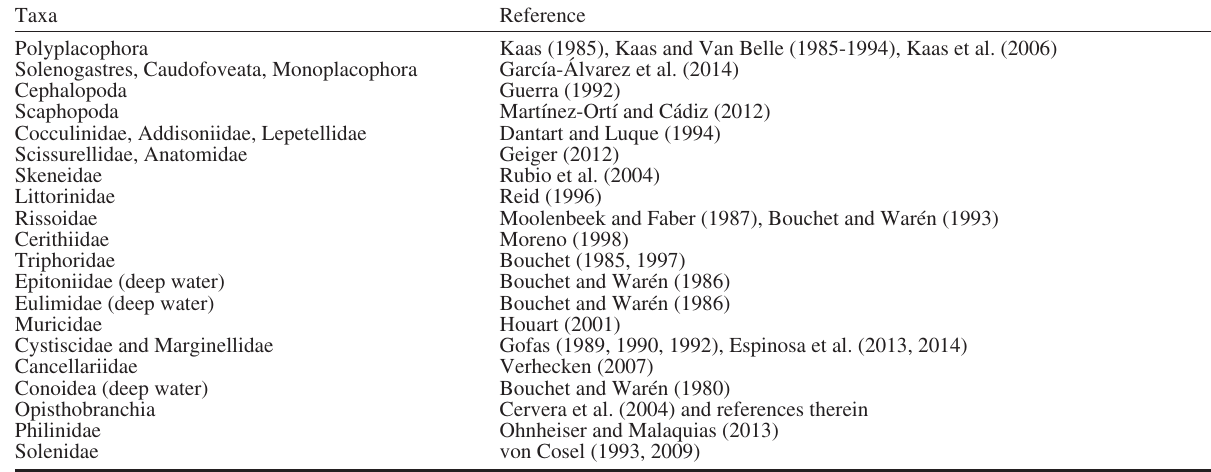
Table 2. – Some main taxon-oriented sources used in establishing the list. Minor sources are listed in WoRMS/MolluscaBase.